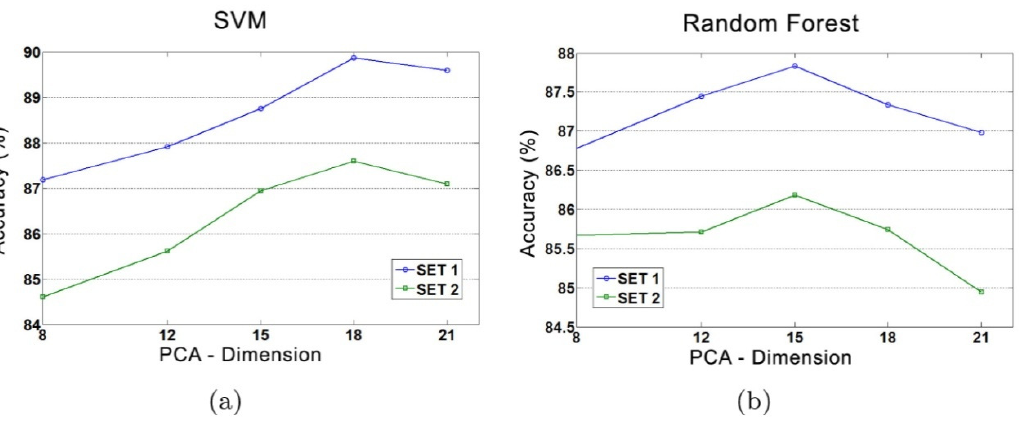
Figure 12. ( a , b ) Show accuracy of SVM with RBF kernel and Random Forest against PCA with different dimensions on UT-Interaction dataset (Set 1 and Set 2). Table 3. Confusion matrix (%) of 2D ‐ DIDGP on Set 1 using SVM with RBF kernel function, where A